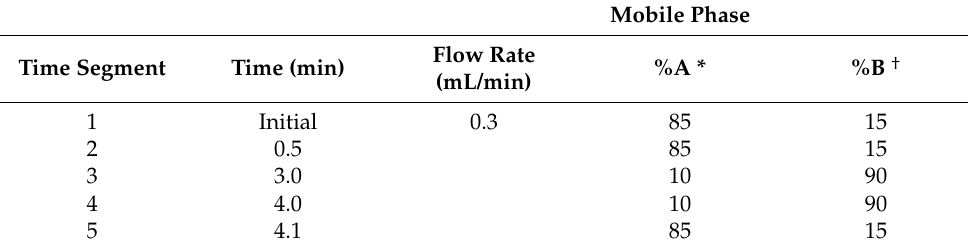
Table 4. Gradient conditions for chromatographic separation for HVA and VMA